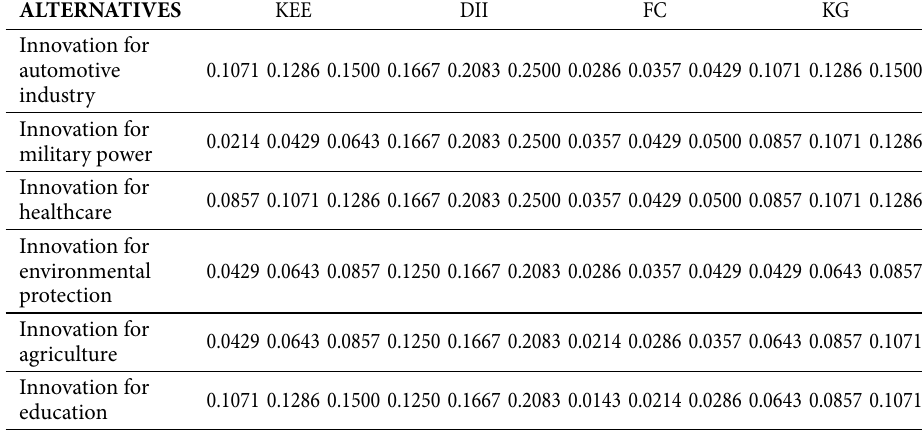
Table 6. Distances to positive ideal solutions ALTERNATIVES